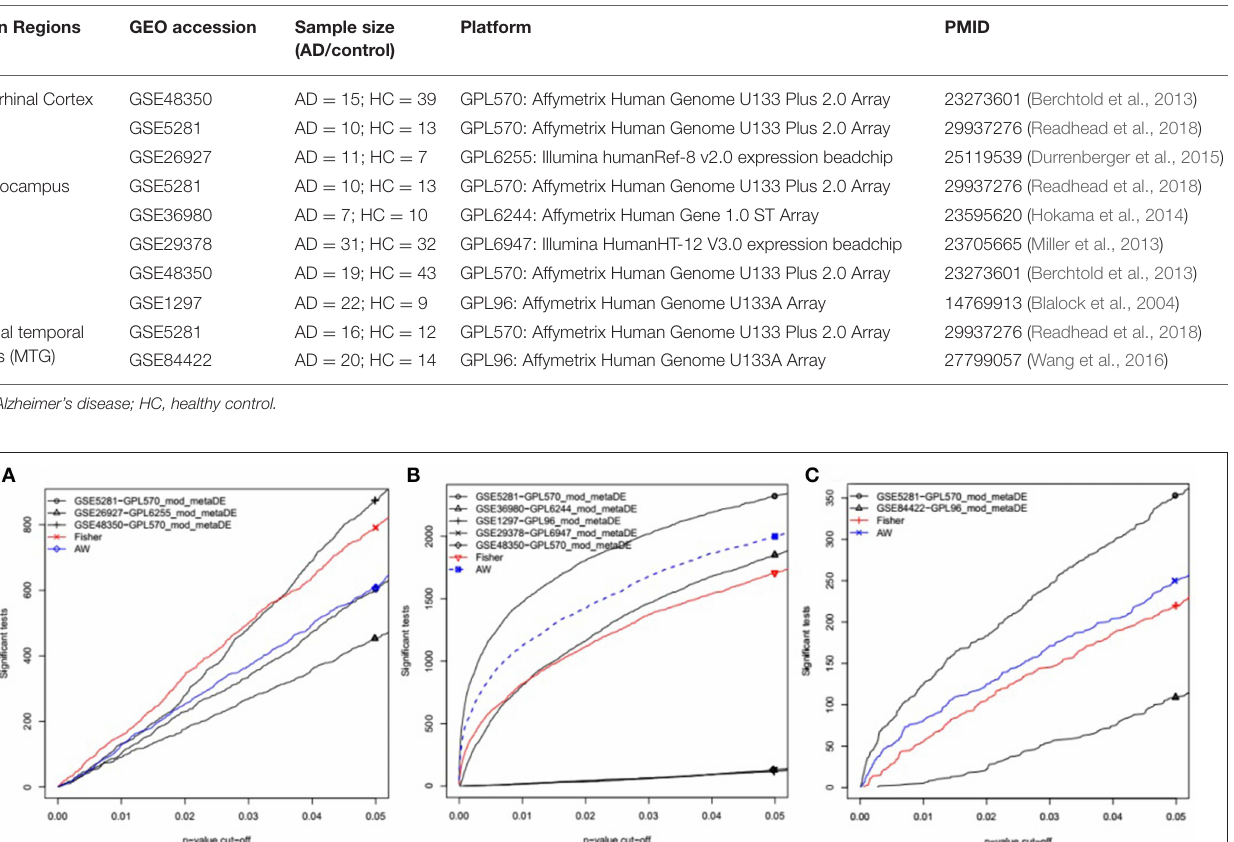
> 1, tau 2 = 0, and FDR > 0.05. The genes with tau 2 = 0 and FDR > 0.05 were considered homogeneous and unbiased, from which the genes with a P < 0.05 in the Fisher’s exact test of the MetaDE package were selected as DEGs. Tau 2 represents the difference among study samples and reflects the heterogeneity between studies. The smaller the tau 2 value, the smaller the